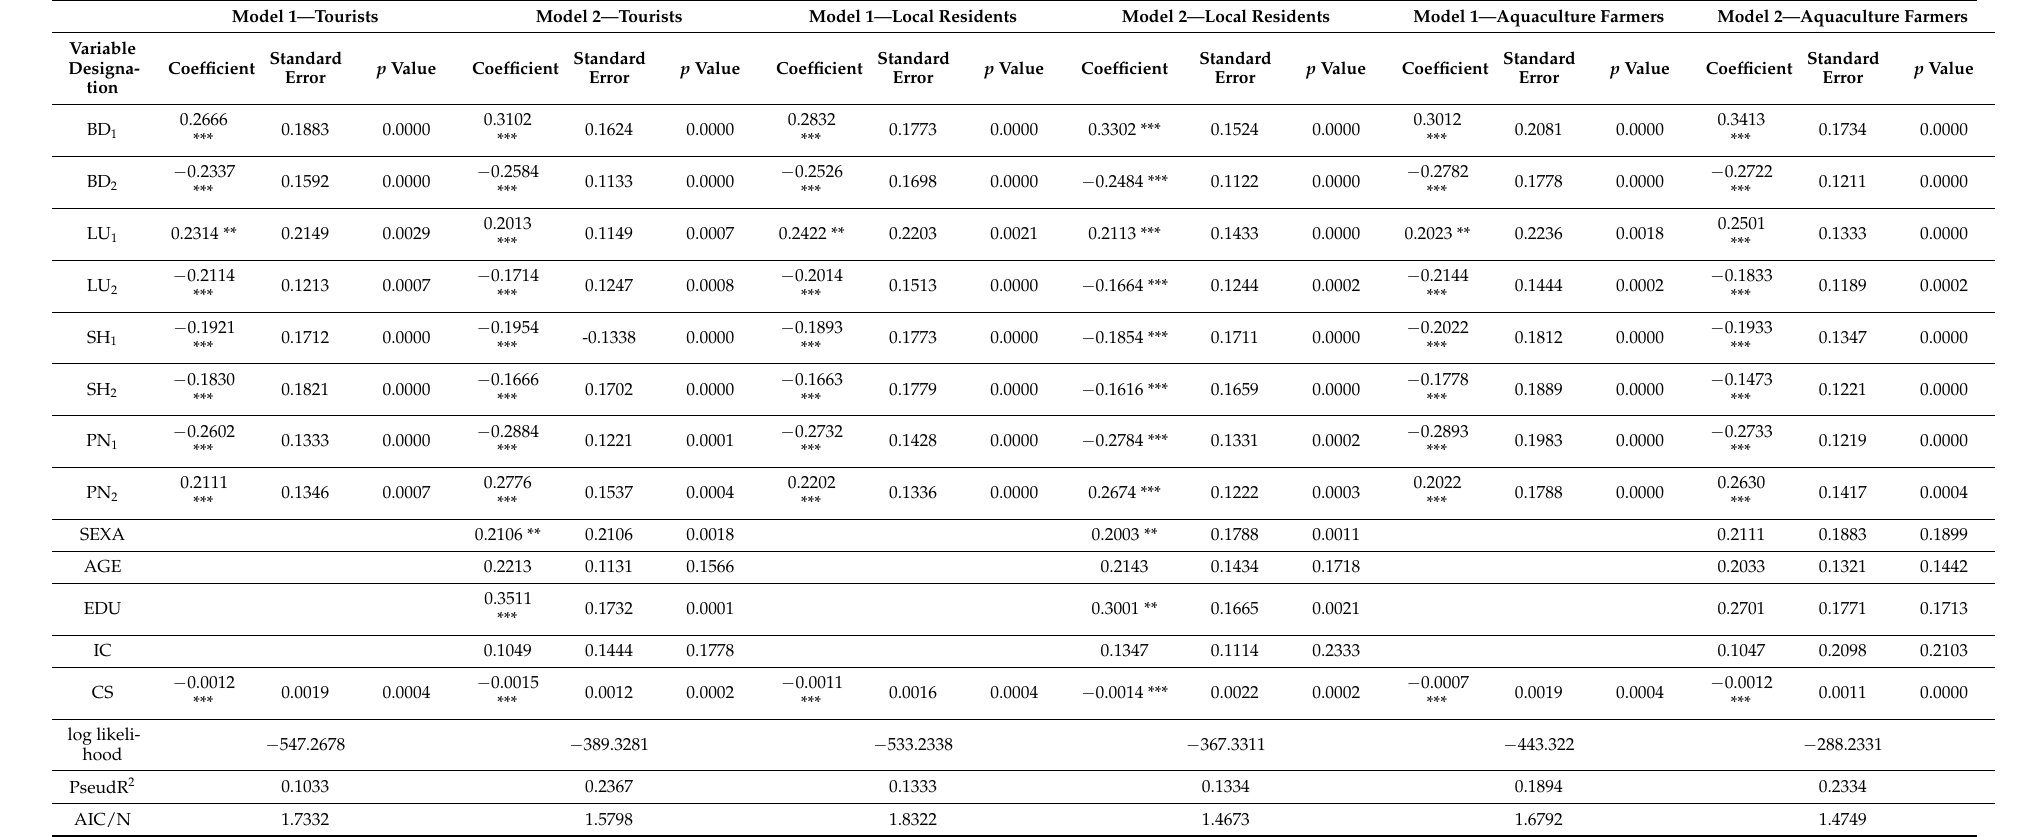
Table 7. Multinomial logit empirical estimation